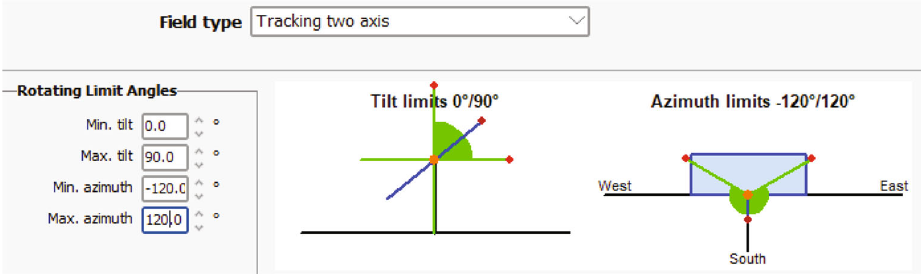
Figure 19: Horizontal and vertical dual-axis solar tracker.